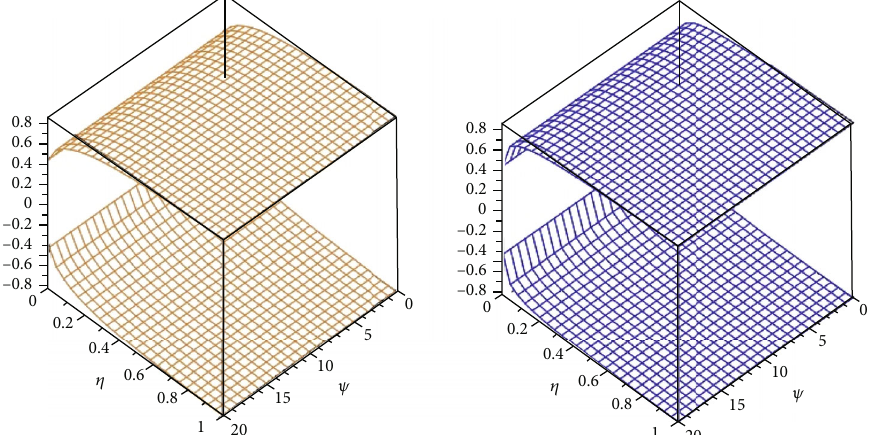
Figure 13: The fi rst graph shows the fuzzy 3D upper and lower fi gure of analytical solution at γ = 0 : 6 and the second graph at fractional of γ = 0 : 4 .